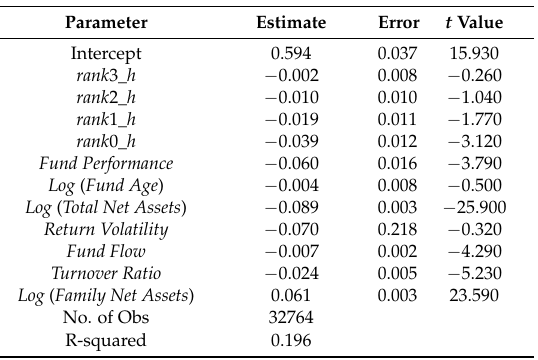
Table 3. Impact of competition on marketing expenses.